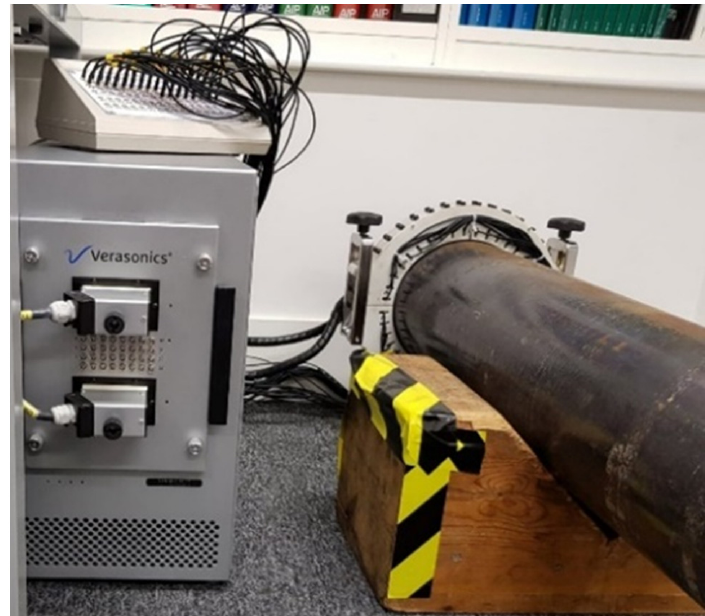
Figure 7. Experimental setup.